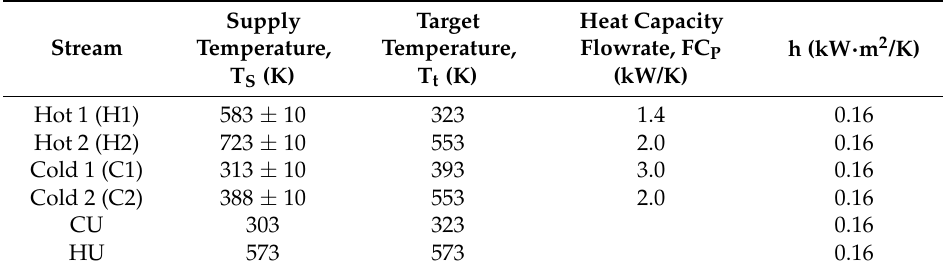
Table 10. Stream data of Case Study 2 [9].